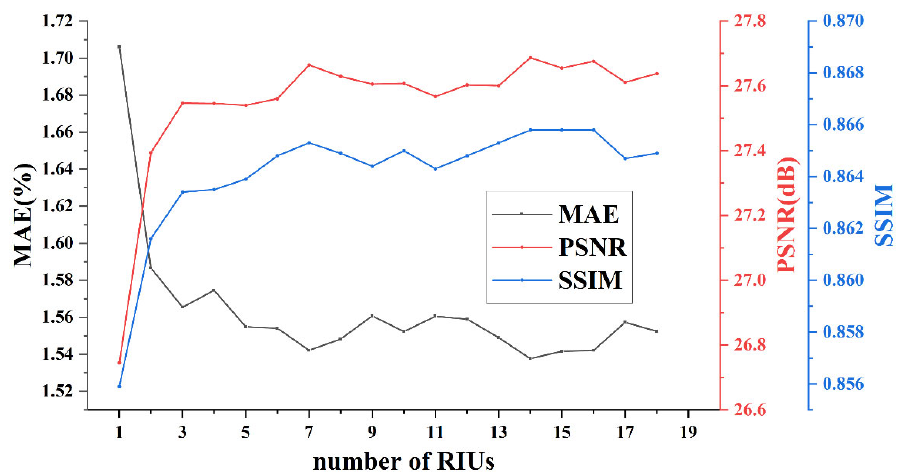
Figure 10. Inpainting quality of different RIU numbers.